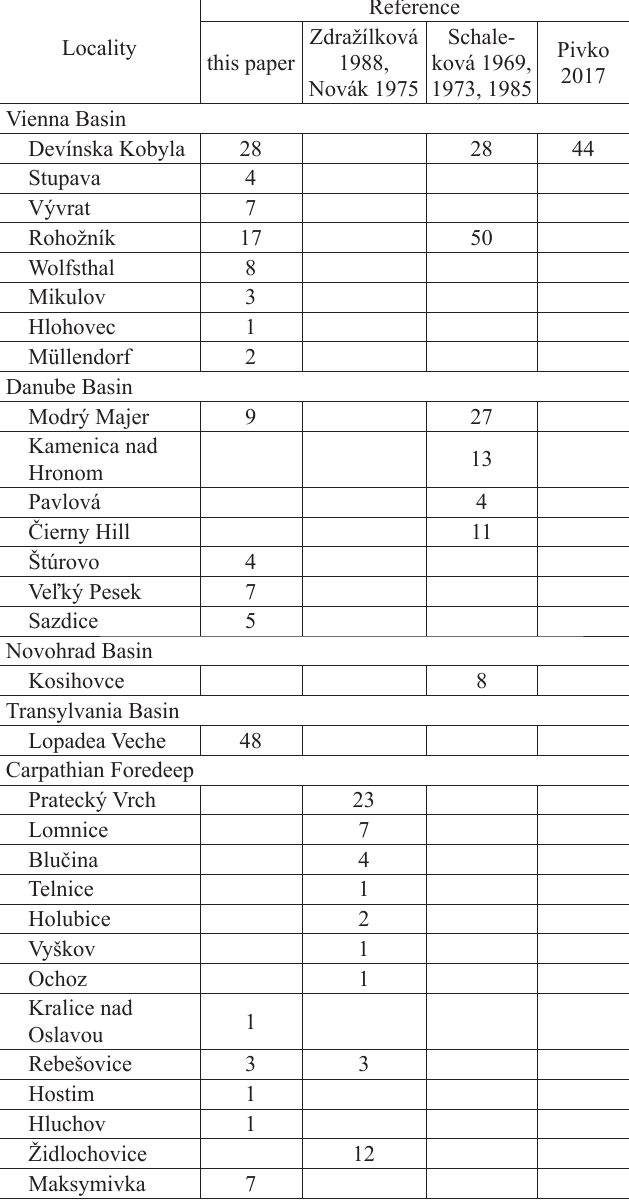
Table 1. The list of the studied material. Numbers indicate number of thin